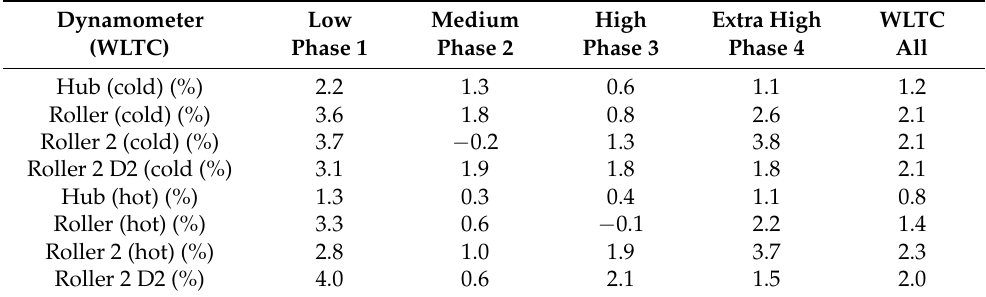
Table 4. IWR (see Materials and Methods) with the roller- and hub-type dynamometers for the cold- and hot-start WLTCs. D2 = second driver.